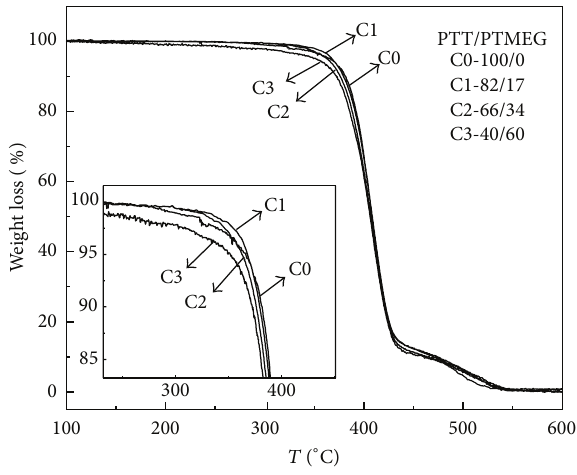
Figure 7: TG curves of the various